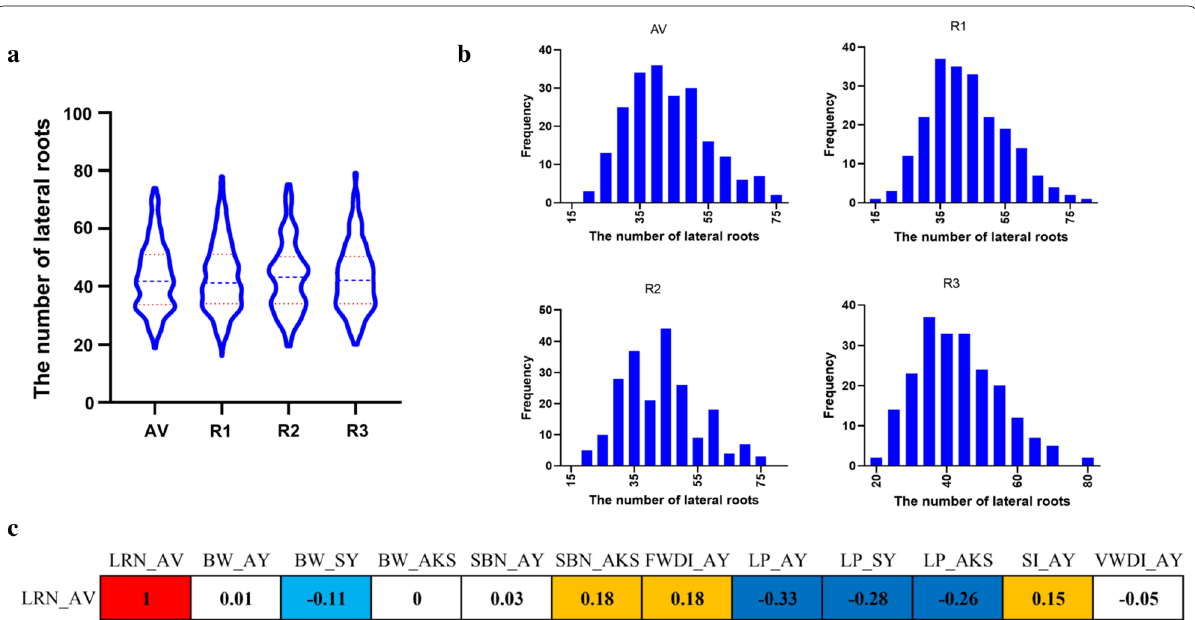
Fig. 2 Frequency and correlation analysis of lateral root number for 215 Gossypium arboreum accessions. a The number of lateral roots observed in 215 G. arboreum accessions. b Frequency of the lateral root number in 215 G. arboreum accessions. c Correlation analysis of LRN_AV with 11 yield and disease resistance-related